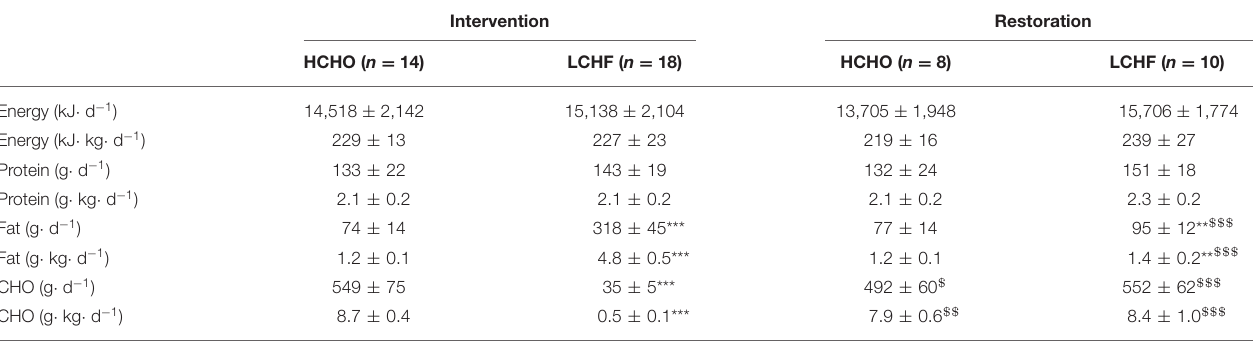
TABLE 1 | Dietary intakes in the HCHO and LCHF groups. Intervention